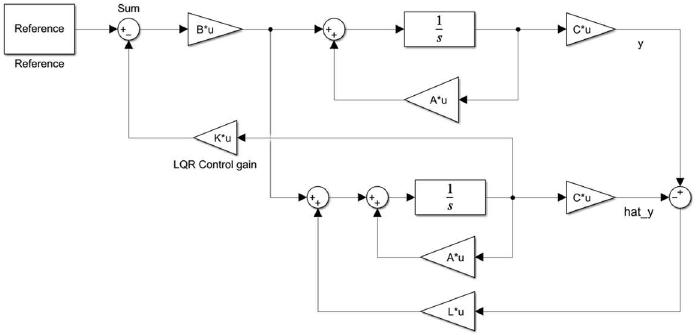
Figure 13. Kalman filter applied motion controller structure.